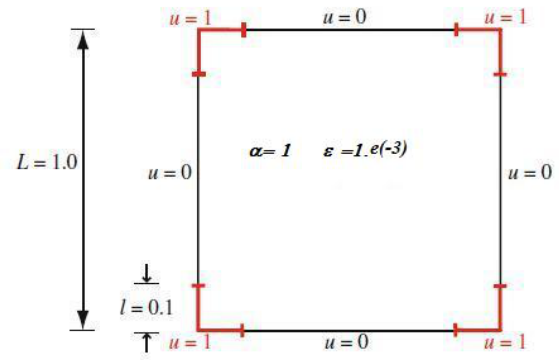
Figure 1. Boundary conditions of example 1.